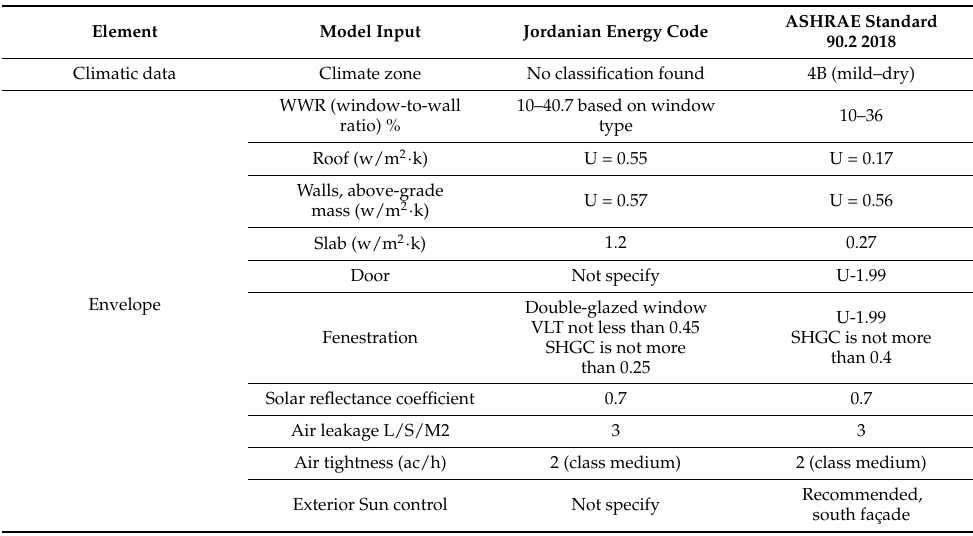
Table 8. The requirements of the Jordanian code and ASHRAE Standard 90.2 2018 for building energy efficiency in mild–dry climate zones